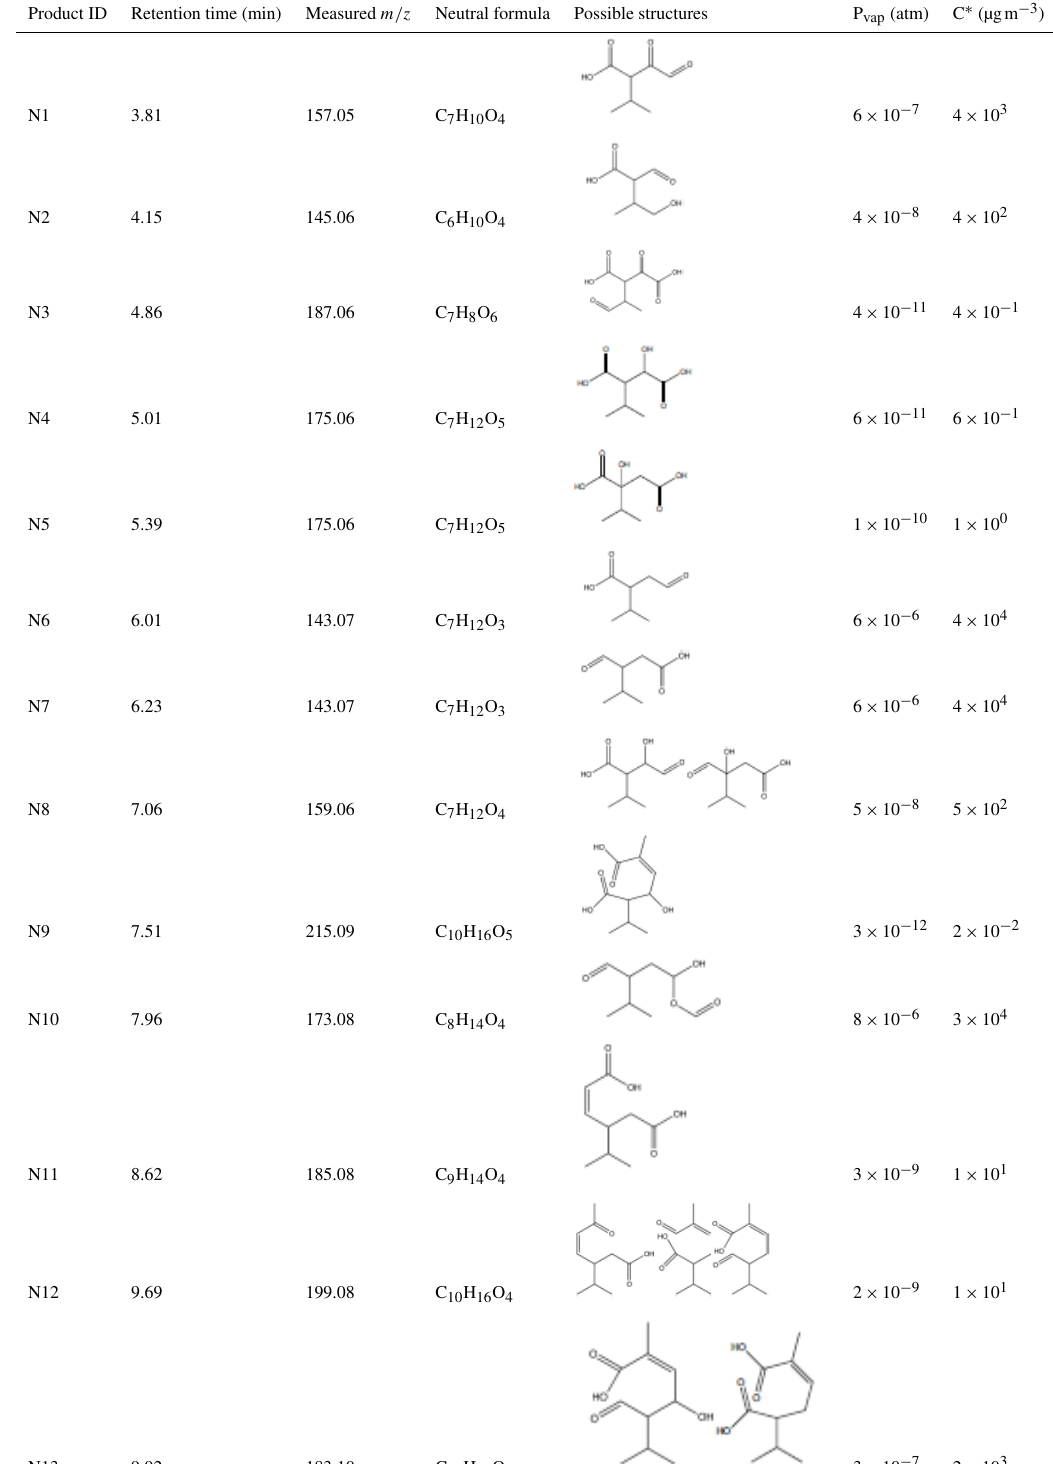
Table 2. Major species detected in negative mode ESI with postulated structures consistent with composition, the mechanism proposed by Mackenzie-Rae et al. (2017) and tandem mass spectra. Estimated saturation vapour pressures ( P vap ) and saturation vapour concentrations (C ∗ ) for each product are also listed. The proposed structure list is not exhaustive, with other isomers existing. Product ID Retention time (min) Measured m/z Neutral formula Possible